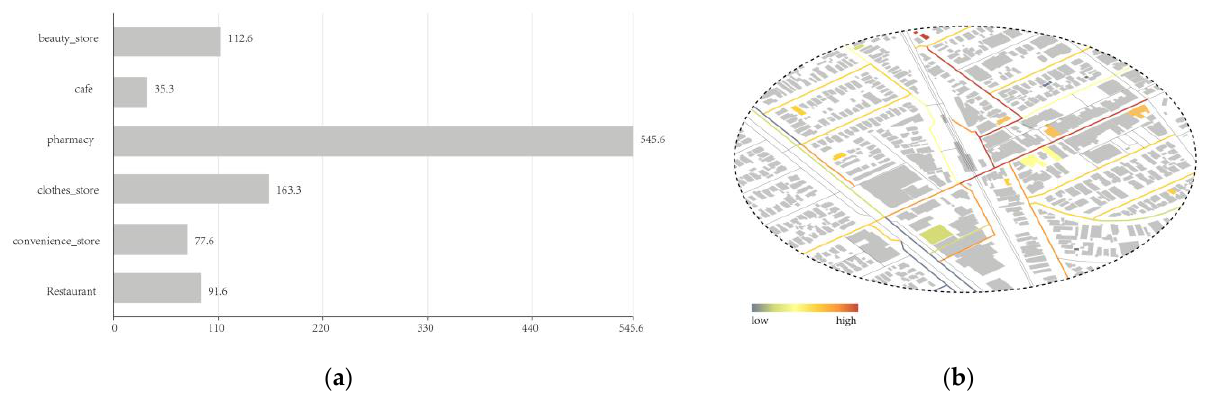
Figure 6. Profile of the study area.